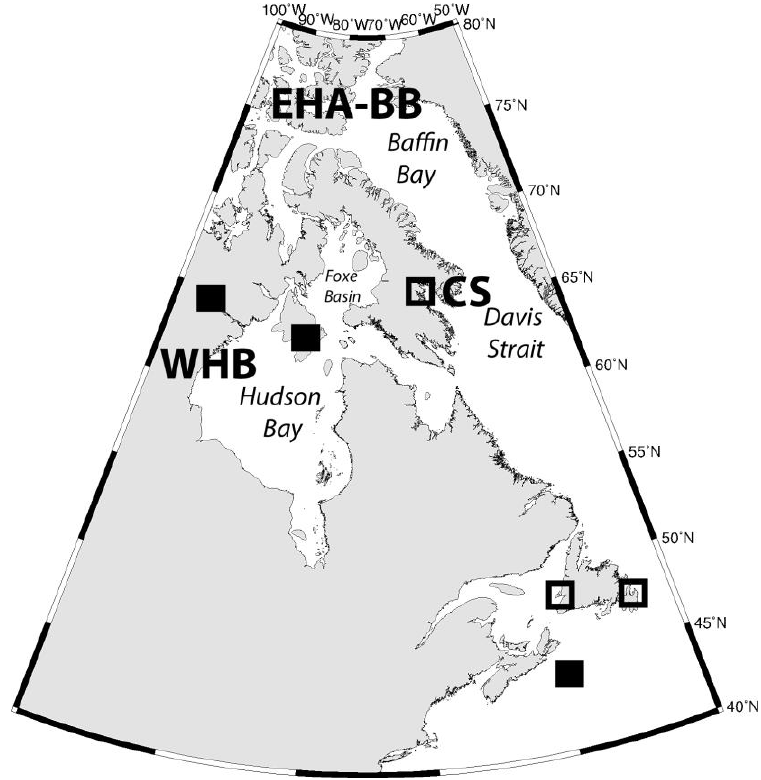
Fig. 1. Teeth were collected from belugas harvested in Arviat, NU (Western Hudson Bay population; ), Pangnirtung, NU (Cumberland Sound population; ), and Grise Fiord (Eastern High Arctic-Baffin Bay population; ) through the 1980s- 2000s. Locations where killer whale specimens were collected throughout the eastern Canadian Arctic, Newfoundland, and Nova Scotia are indicated by closed (single specimen) and open (two specimens)